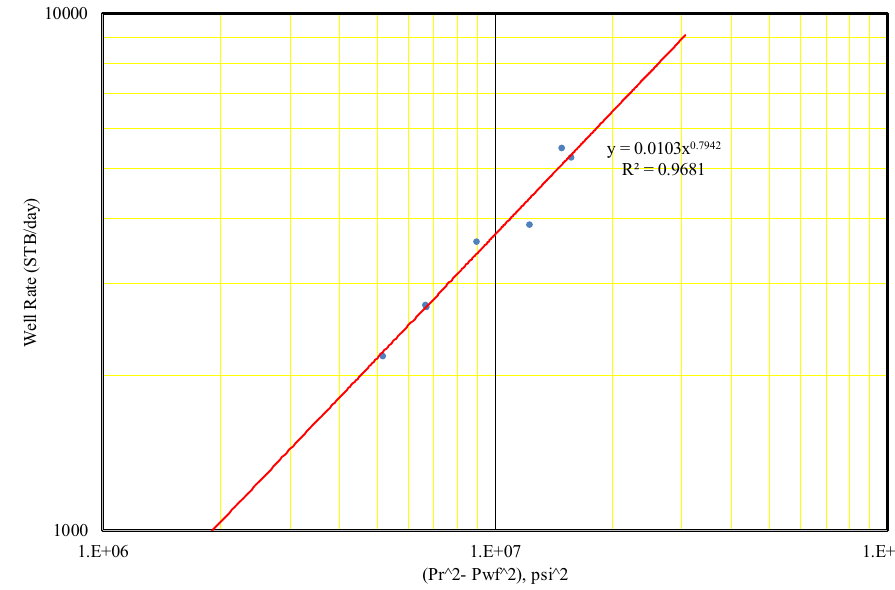
Fig. 3 IPR of well ‘B-1’